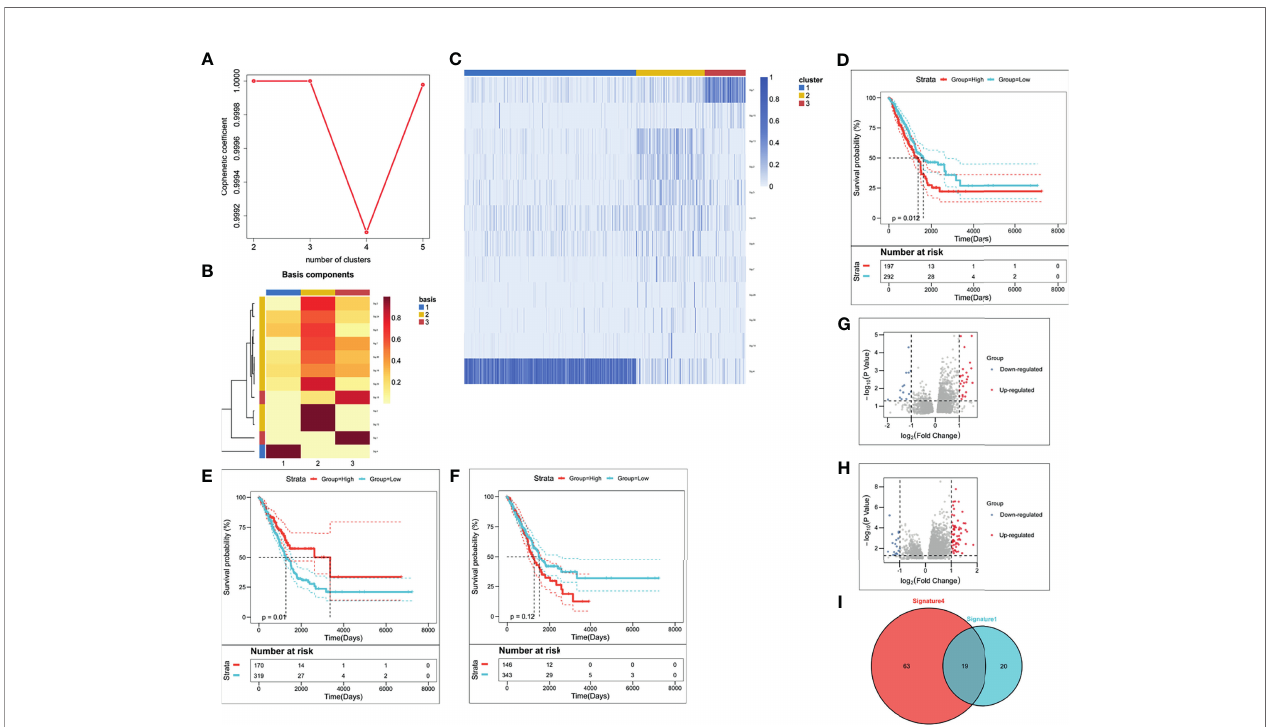
FIGURE 1 | The identi fi cation of LUAD-related immune biomarkers. (A) The diagnostic diagram of mutation signature for setting cophenetic correlation coef fi cient value as three. (B) The evaluation of weight scores for each mutation signature in each sample by setting 6% as cut-off value. (C) The identi fi cation of driving mutation signatures. (D – F) Kaplan – Meier curves of signature 1 (D) , signature 4 (E) , and signature 13 (F) . (G, H) The selection of differentially expressed genes in signature 1 (G) and signature 4 (H) . (I) There were thirty-nine DEGs in signature 1 and eighty-two DEGs in signature